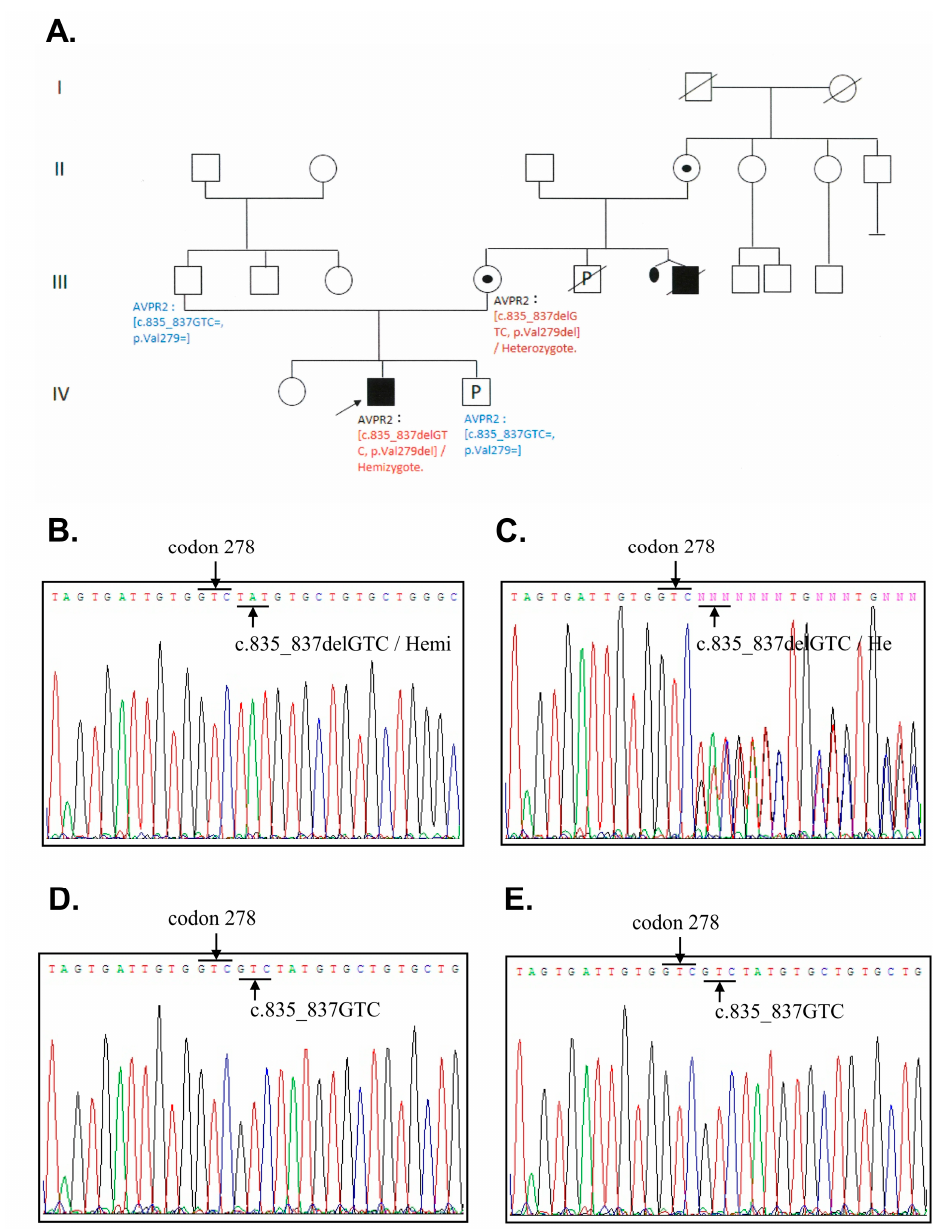
Figure 1. Pedigree of congenital nephrogenic diabetes insipidus and DNA sequencing analyses in the patient’s family. ( A ) Black and white symbols represent clinically affected and unaffected individuals, respectively. The arrow indicates the proband. ( B – E ) Arrows represent the area of codon 278 and 279. ( B ) The patient’s DNA sequencing results revealed a hemizygous mutation with a deletion at codon 279 in exon 2 (c.835_837delGTC, p.Val279del). The codon next to codon 278 (GTC) is TAT as indicated by the underline. There should be an additional codon GTC (Val) at the position 279 in between GTC at codon 278 and the TAT (should be at codon 280). ( C ) The patient’s mother revealed a heterozygous mutation with a deletion mutation at codon 279 in exon 2 (c.835_837delGTC, p.Val279del). ( D ) That of the patient’s father showed normal at codon 279 in exon 2. ( E ) That of the fetus showed normal at codon 279 in exon 2.